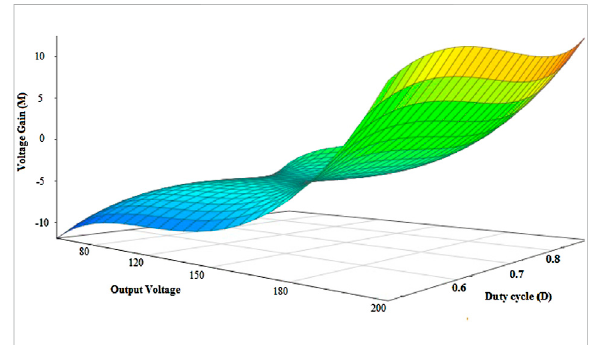
FIGURE 11 Diagram of voltage gain, duty cycle (D), and output voltage.